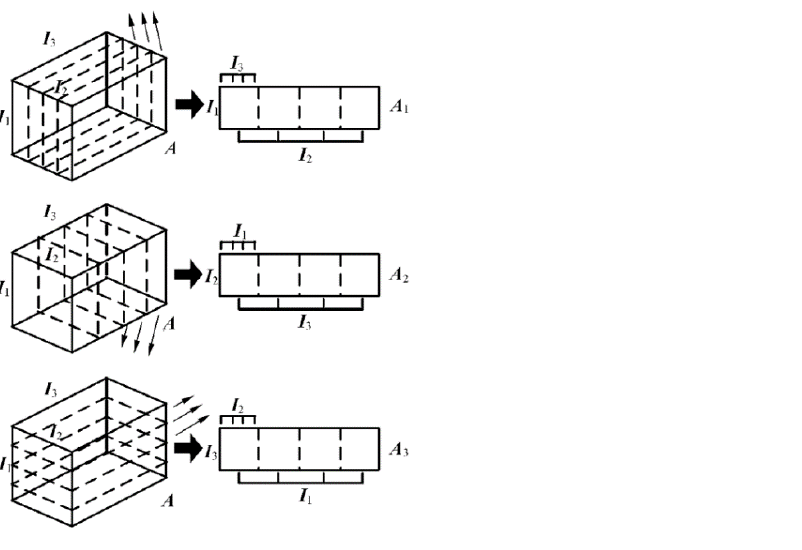
Figure 1. Two-dimensional matrix expansion of a three-dimensional tensor. (The thinner arrow on the left side of the figure represents the direction of tensor expansion)